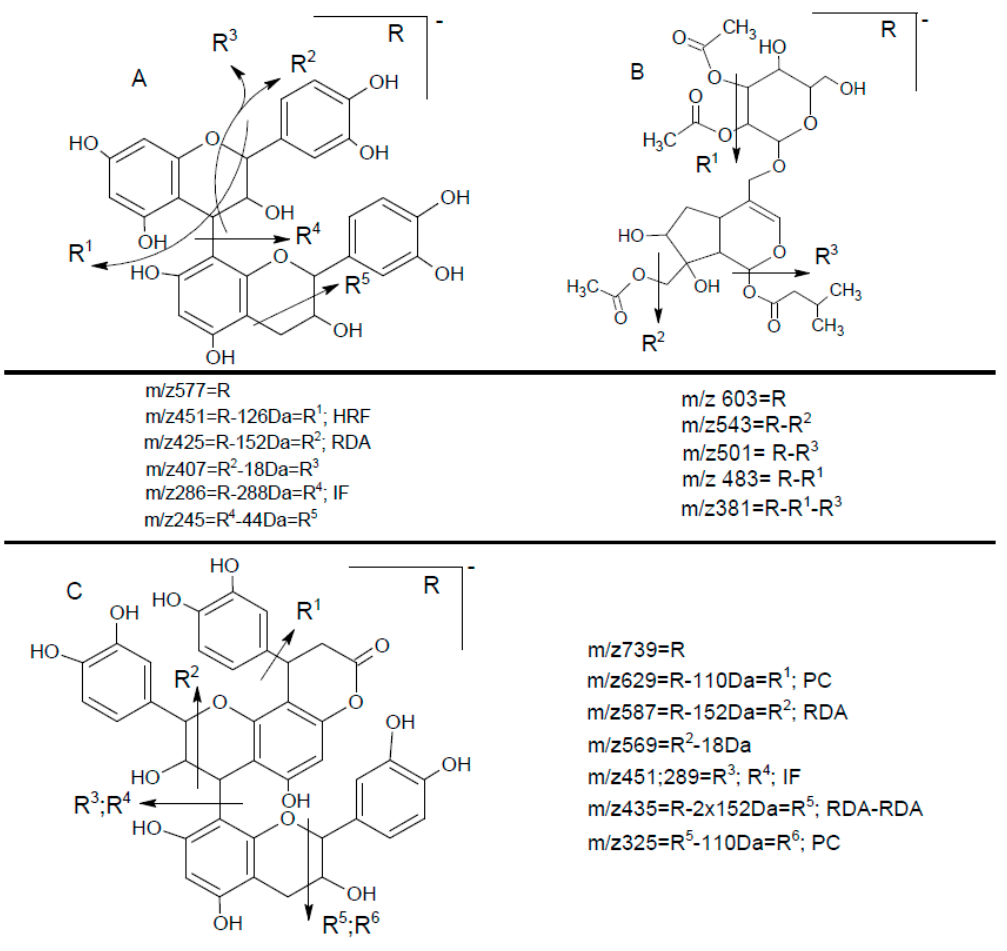
Figure 2. Hypothetic structures of selected daughter ions resulting from MS-MS fragmentation of the compound 13 procyanidin dimer B2 ( A ), 45 opulus iridoid II ( B ), and 28 cinchonain IIx ( C ). HRF—heterocyclic ring fussion; PC—phenyl cleavage; RDA—retro-Diels-Alder reaction; IF—interflavan fussion.